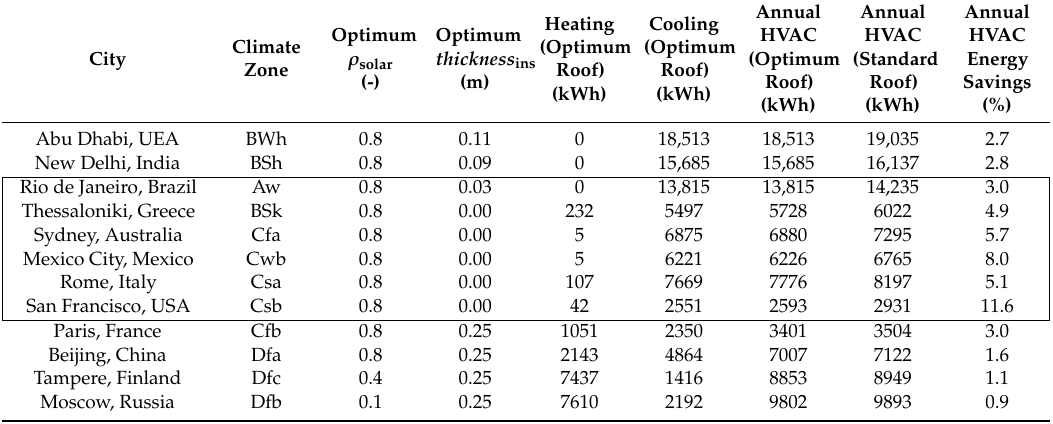
Table 6. Heating, cooling, and annual HVAC energy consumption and energy savings with the optimum roof configuration compared to the standard roof for the case study building in each climate.